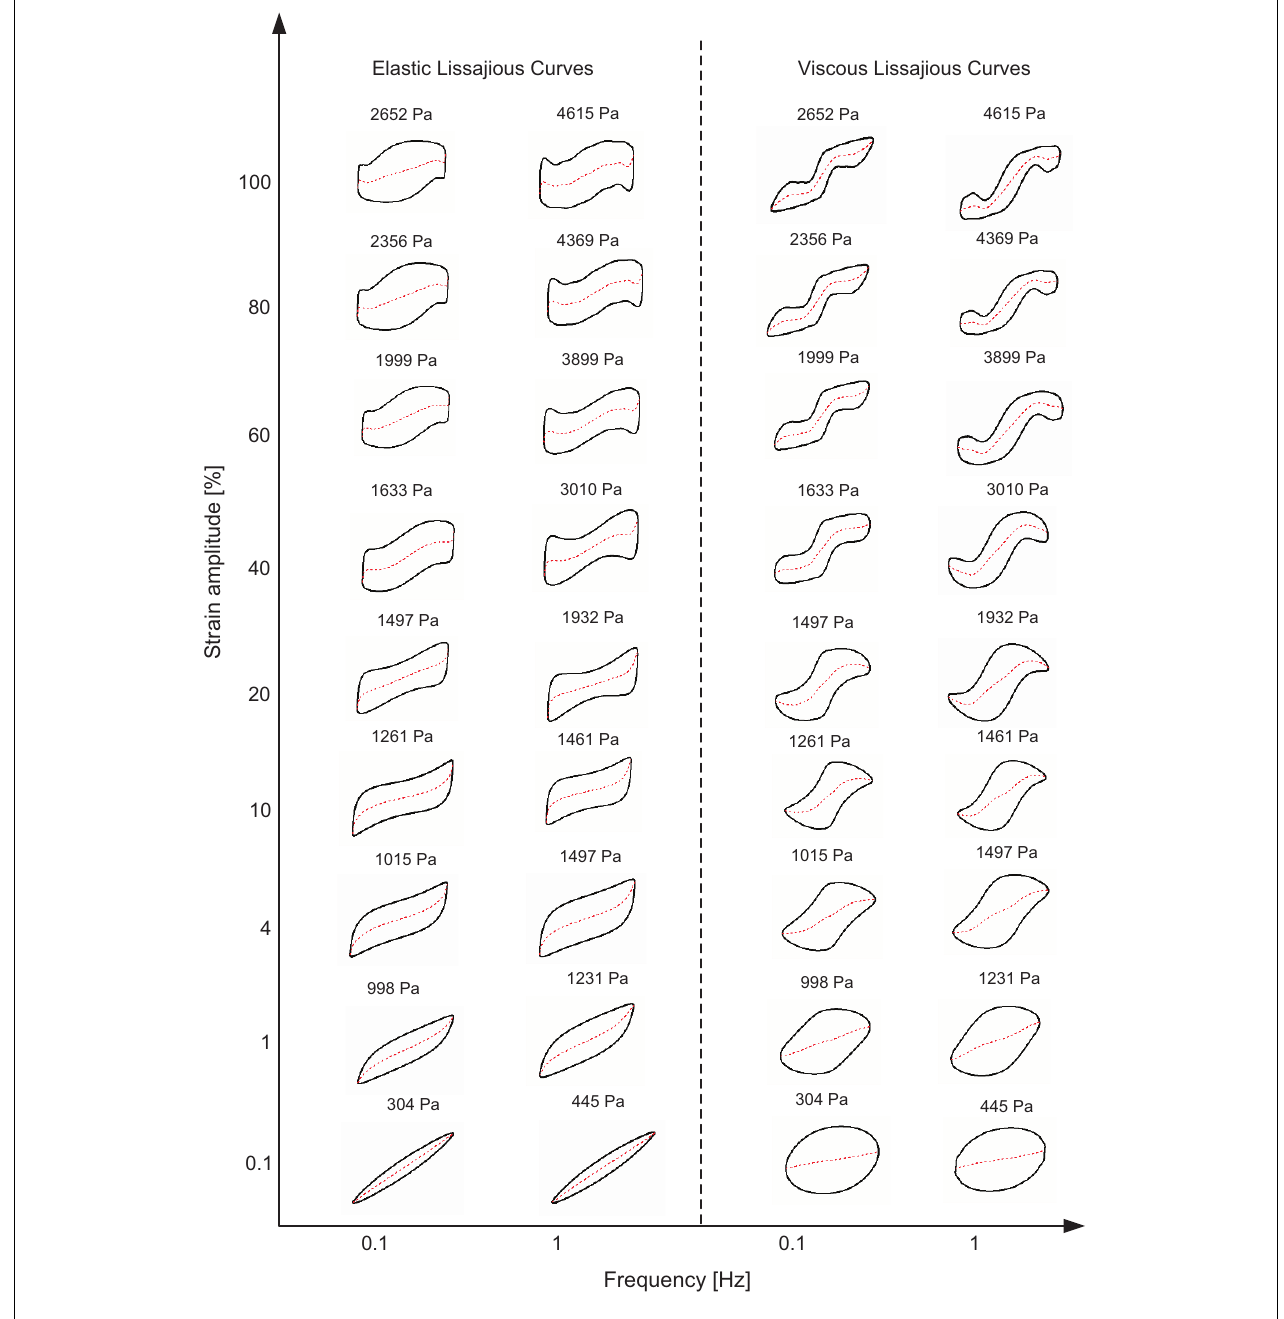
FIGURE 6 | Elastic and viscous Lissajous curves of MRG-70 generated from the strain-controlled oscillatory shear under the magnetic field of 96 kA/m. Each curve is positioned according to the imposed value of shear strain and frequency. The red dash line represents the corresponding decomposed elastic and viscous stress. The value above each curve is the maximum shear stress τ max